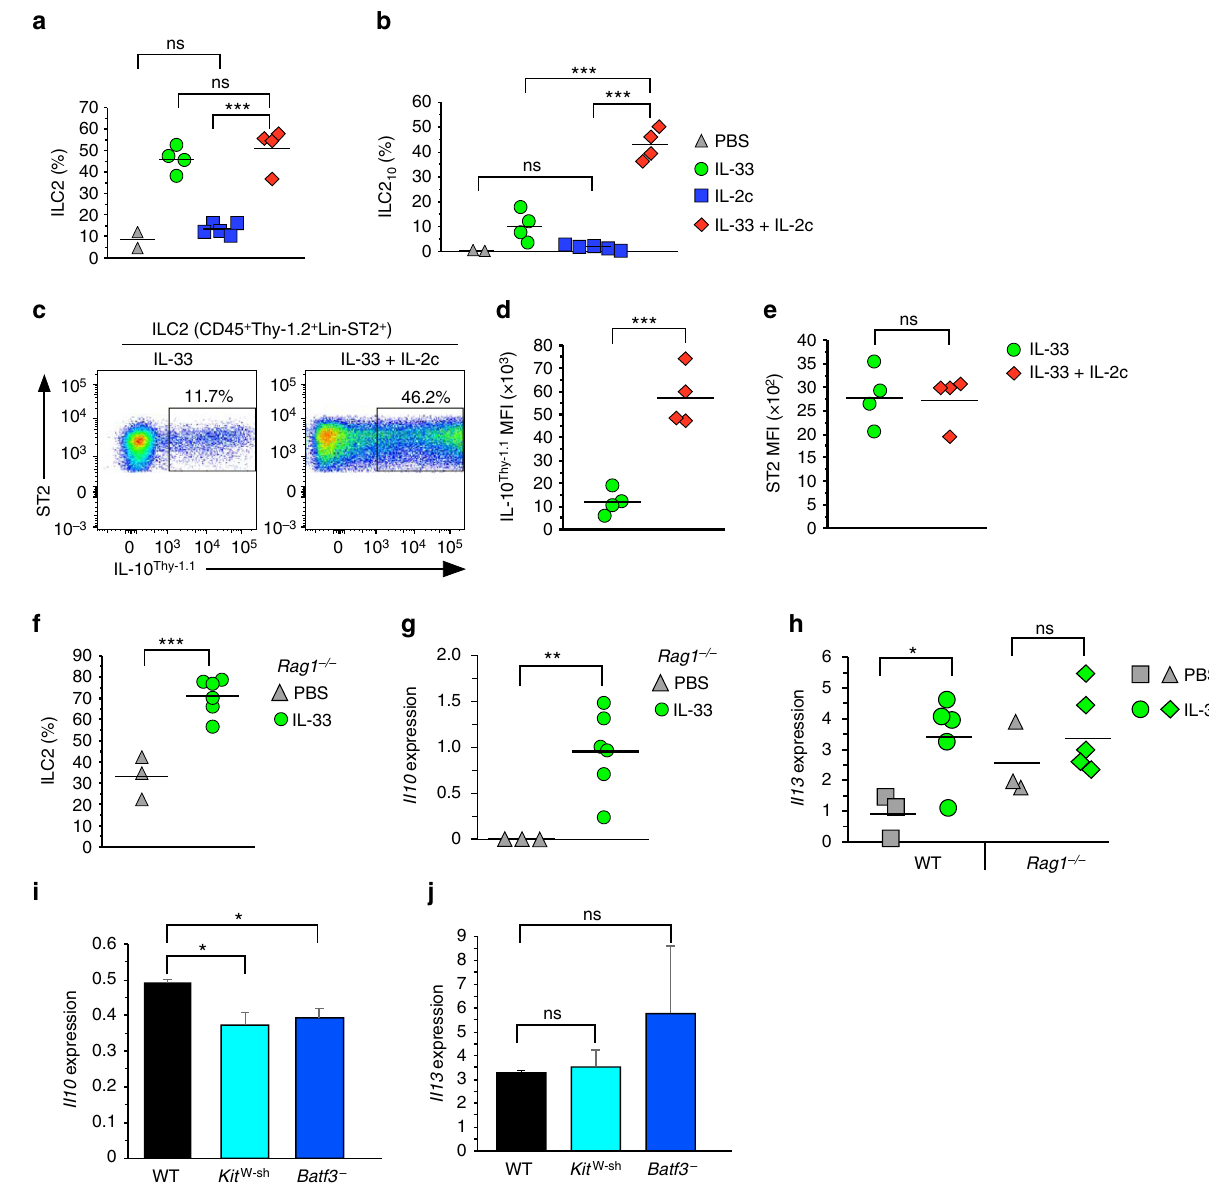
Fig. 6 IL-2 complex enhances ILC2 10 effector cell generation in vivo. a , b Frequency of ILC2 ( a ) or ILC2 10 ( b ) from the lungs of 10BiT Foxp3 GFP dual reporter mice treated for four consecutive days as indicated. c Flow cytometry analysis of ILC2 10 from mice injected with either IL-33 alone or IL-33 and IL-2c as a frequency of total ILC2 (Lin – CD45 + Thy-1.2 + ST2 + ). d , e Thy-1.1 ( d ) or ST2 ( e ) MFI, gated as in c . f Frequency of ILC2 within the CD45 + Thy-1.2 + cell population from PBS or IL-33-treated Rag1 – / – mice. g , h Quantitative RT-PCR analysis of Il10 ( g ) or Il13 ( h ) gene expression in ILC2 sorted from wildtype (WT) or Rag1 – / – mice with indicated treatments. i , j ILC2 were sort puri fi ed from IL-33 injected animals de fi cient in either mast cells ( Kit W-sh ) or CD103 + dendritic cells ( Batf3 – ) and analyzed for Il10 ( i ) or Il13 ( j ) gene expression. Data are from two or three independent experiments with representative plot shown in c , compiled data on individual mice shown in a , b , d , e , f , g , h , and mean+standard deviation in i , j . *** P < 0.001, ** P < 0.01, * P < 0.05 and ns (not signi fi cant, P > 0.05) (Student ’ s t